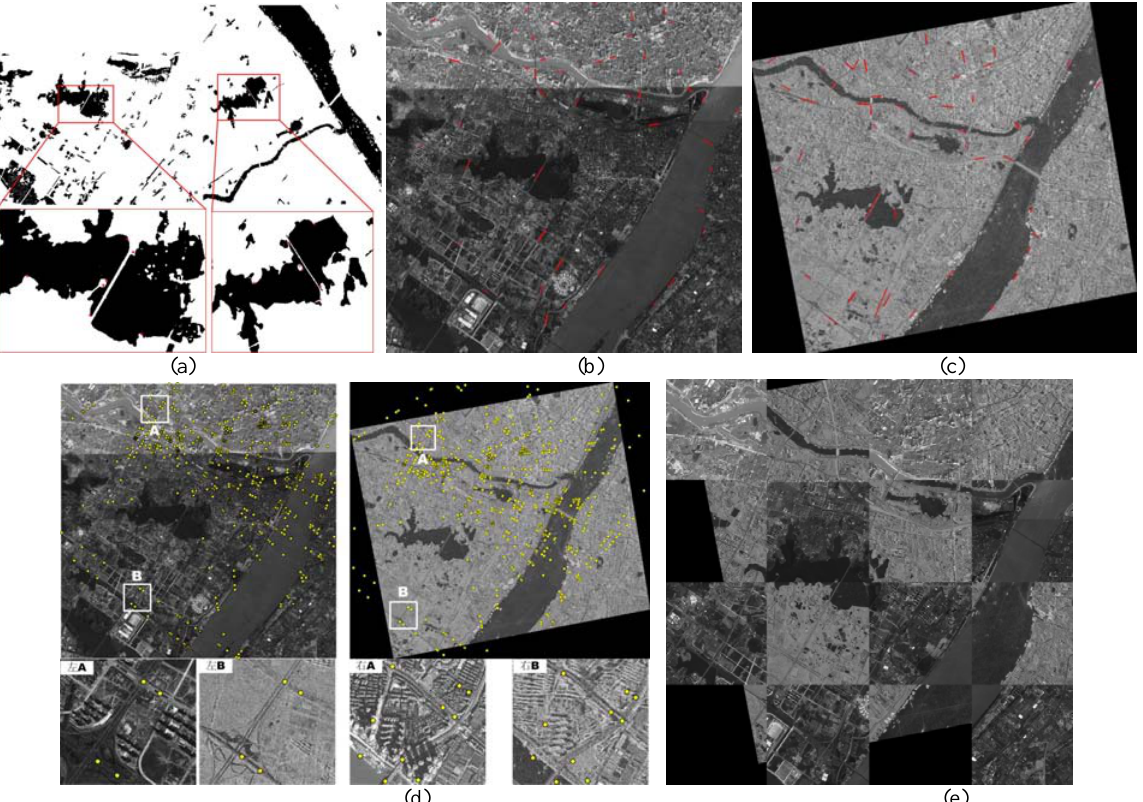
Figure 2. Registration result using area and line features of dataset1. (a) Image segment result and final set of tie points of the optical image (left) and SAR image (right) using iterative level set segmentation and matching method. (b) Line segments extraction for optical image. (c) Line segments extraction for registered SAR image. (d) Tie points of optical image (left) and SAR image (right) using line extraction and VSPM. (e) (e) The chessboard overlay result using area and line features.